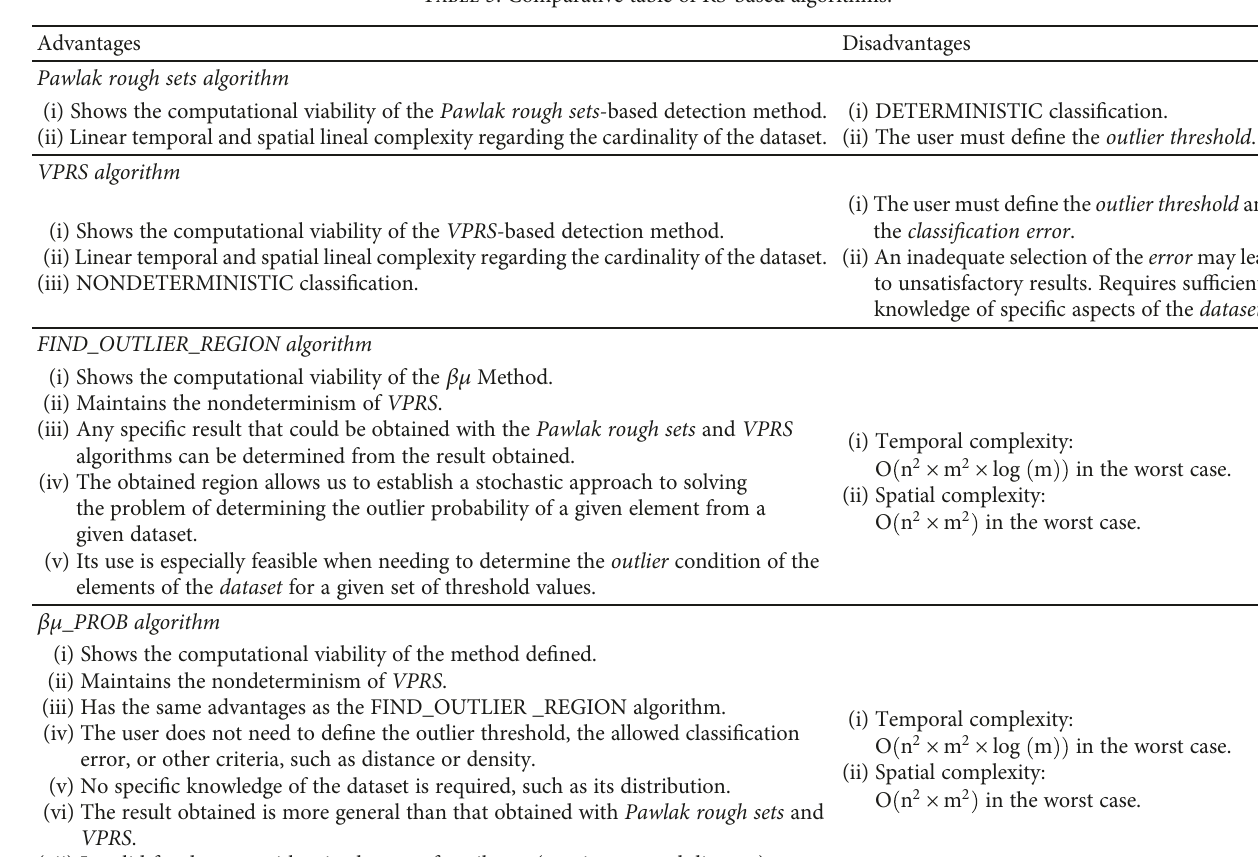
Table 5: Comparative table of RS-based